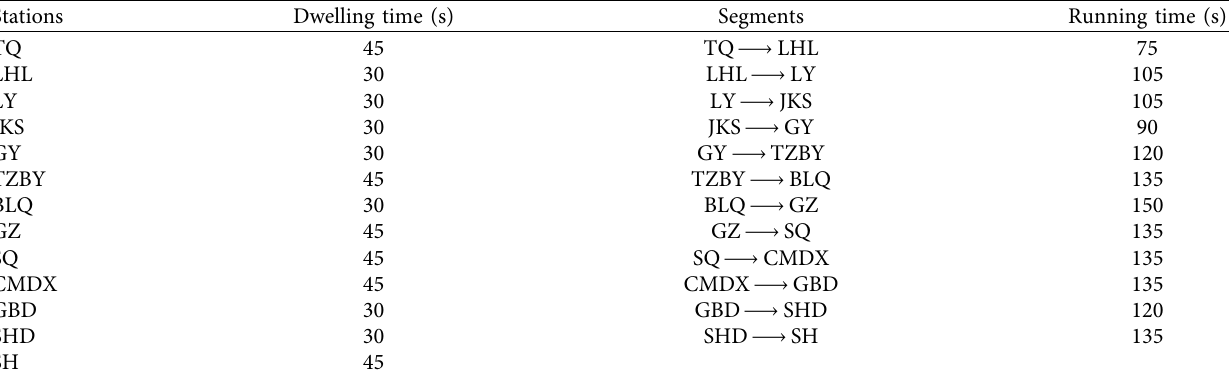
Table 5: Dwelling time and running